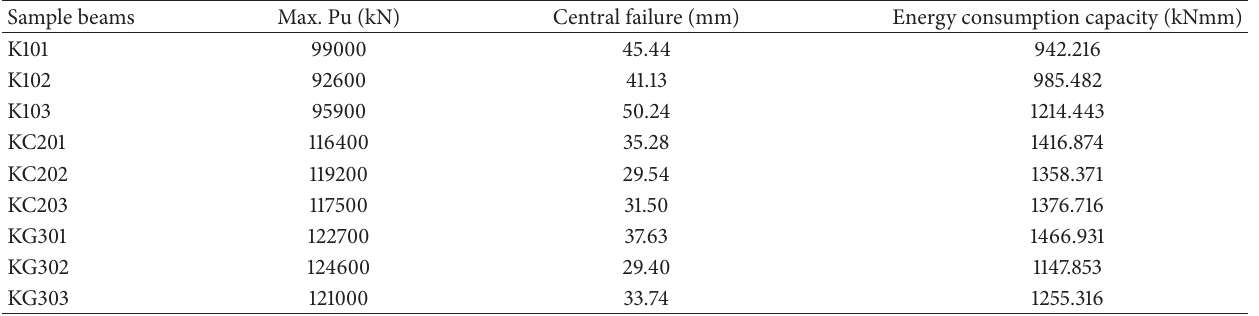
Table 8: Energy consumption capacity of the